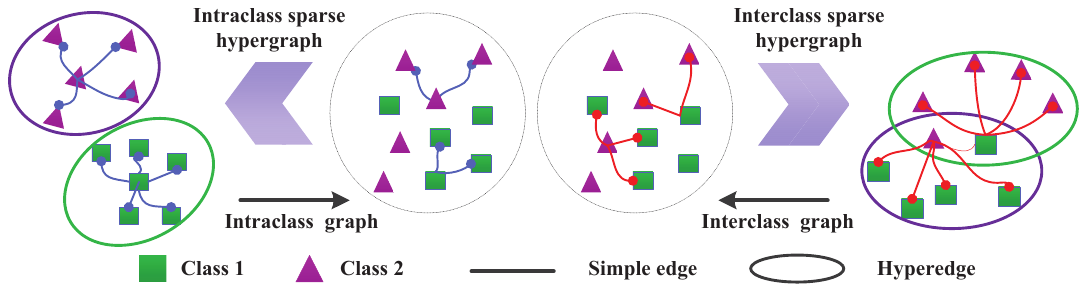
Figure 3. A simple two classification model to explain the construction of sparse